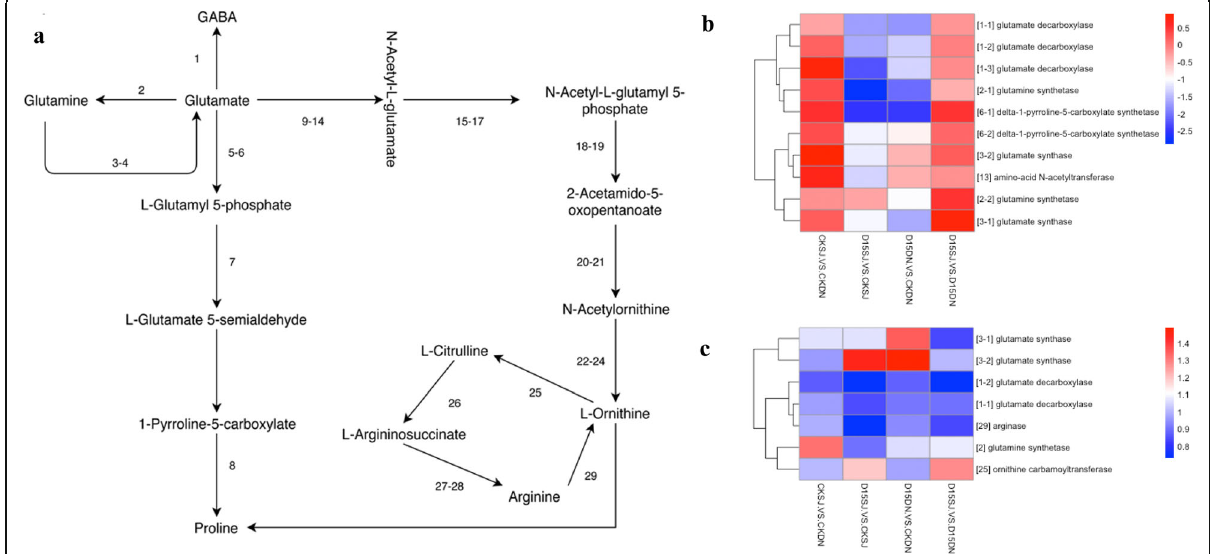
Fig. 7 Expression differences in the amino acid metabolism pathways of the transcriptome and proteome. a, Amino acid metabolism pathway in KEGG pathway database. b, Differentially expressed genes in the amino acid metabolism pathway of the transcriptome. c, Differentially expressed proteins in the amino acid metabolism pathway of the